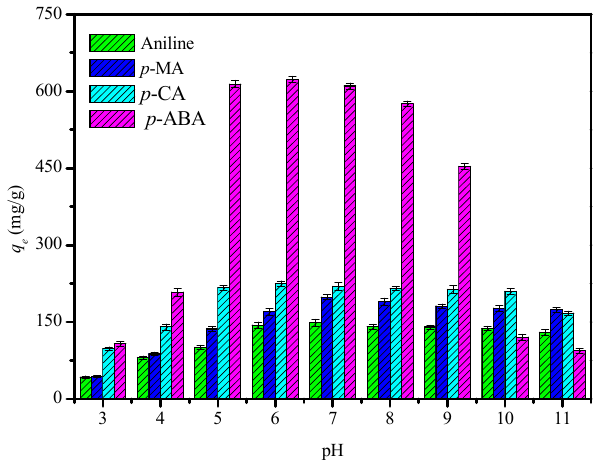
Figure 7. E ff ect of pH on the adsorption of anilines by the CDM-HCP. Figure 7. Effect of pH on the adsorption of anilines by the CDM-HCP.